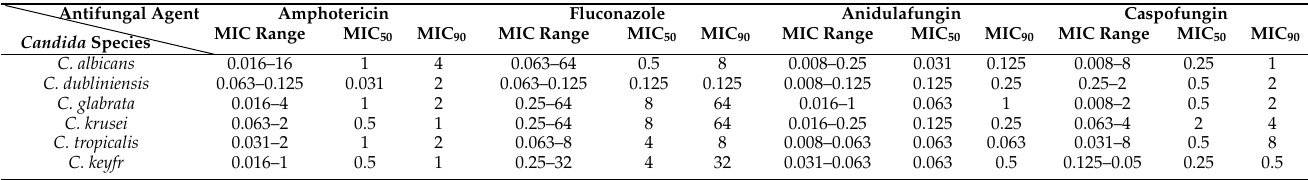
Table 1. Comparison of in vitro susceptibilities of different Candida species to conventional antifungal agents. Adapted from [29], BMC Infectious Diseases, 2018.